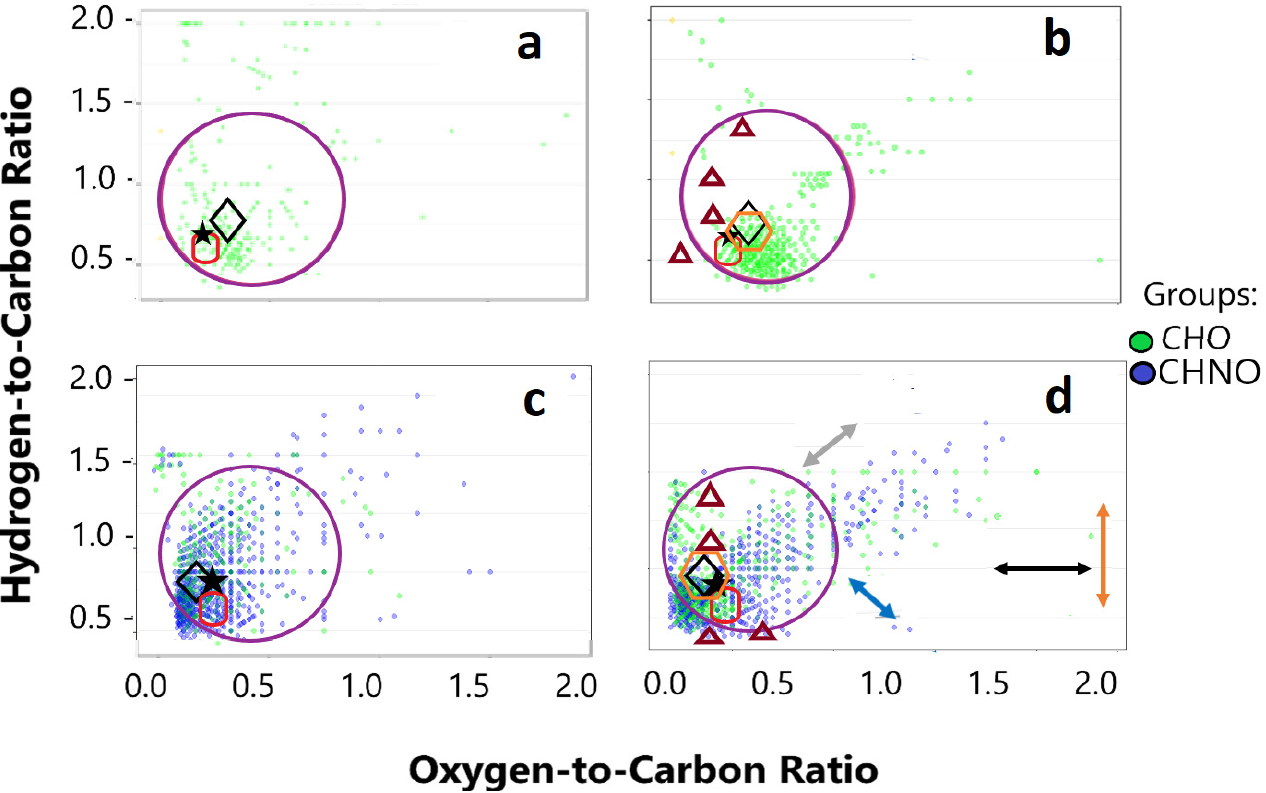
Figure 4. van Krevelen diagrams for 1,8-DHN ( a ) and 1,8-DHN with 5% H 2 O 2 ( b ), 5,6-DHI ( c ), and 5,6-DHI with 5% H 2 O 2 ( d ), in (-) ESI mode. All samples were diluted in water by 1:20. Red-colored regions show the average molar ratios for DHN/DHI-melanin. Purple circles show molar ratios for standard SRHA/SRFA. Black-colored diamond shapes show the original precursor’s molar ratios for each precursor. The colored arrows represent suggested reaction pathways, black: oxidation/reduction, orange: hydrogenation/dehydrogenation, blue: methylation/demethylation (possibly polymerization), and grey: hydration/condensation [51] . The black star in each diagram marks the molar ratios for dimers, H/C: 0.635, O/C: 25 for 5,6-DHI dimer, H/C: 0.6, O/C: 0.2 for 1,8-DHN dimer. The orange hexagon shows the molar ratio ranges for the most abundant assigned formulas in Tables S1 and S2. The brown triangles mark the molar ratios for the molecular formulas of higher masses assigned by MALDI-MS. Original 1,8-DHN solution: pH = 6.0, original 5,6-DHI solution: pH = 6.5, aged 1,8-DHN: pH = 7.0, aged 5,6-DHI: pH = 7.0.